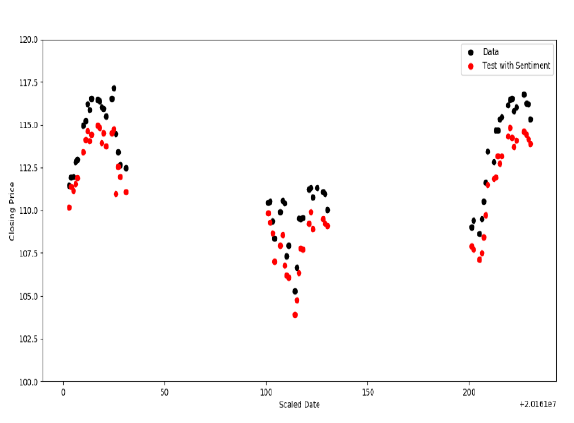
Figure 8 . Values AAPL stock generated by the Perceptron network fitted on the actual values from 03-10-2016 to 30-12-2016 Table 10 is the tabular representation of the comparison of actual vs predicted values for the period 03-10-2016 to 30-12-2016. In this 1/4 th dataset of 04-01-2016 to 30-12-